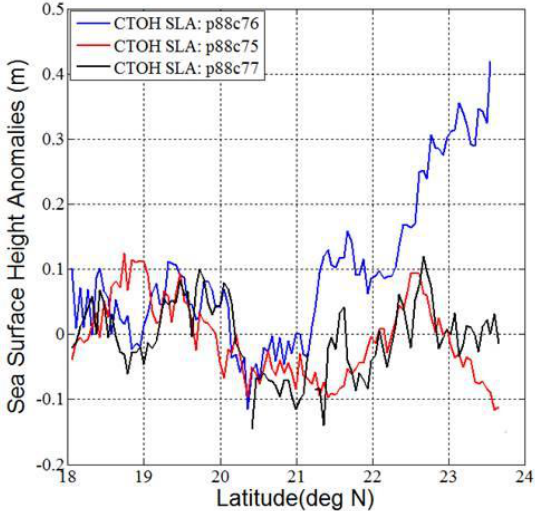
Figure 5. Altimetric sea surface height anomalies along Track 88 observed by T/P. Blue: Cycle 76 during Typhoon Seth. Red: Cycle 75. Black: Cycle 77. CTOH, Centre for Topographic studies of the Ocean and Hydrosphere. SLA, Sea Level Anomalies.